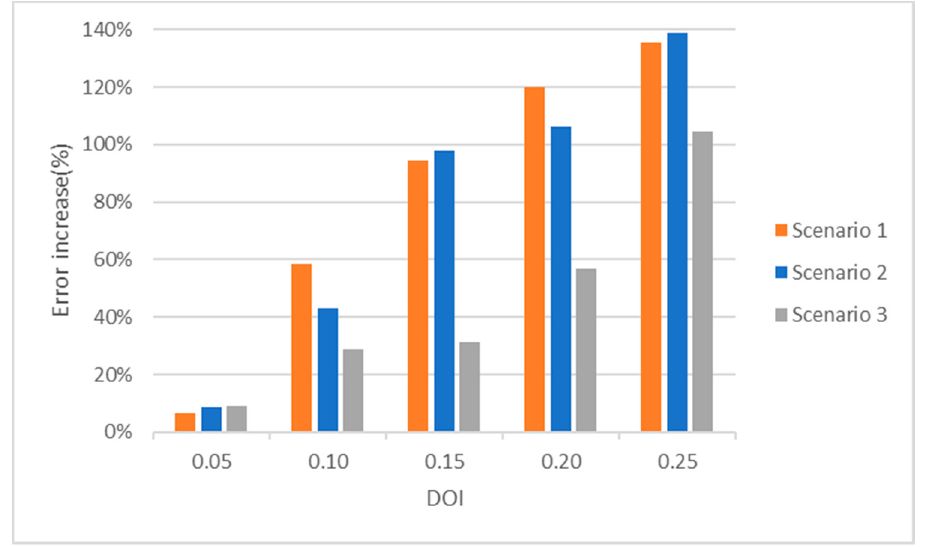
Figure 18. Error increase vs. DOI.